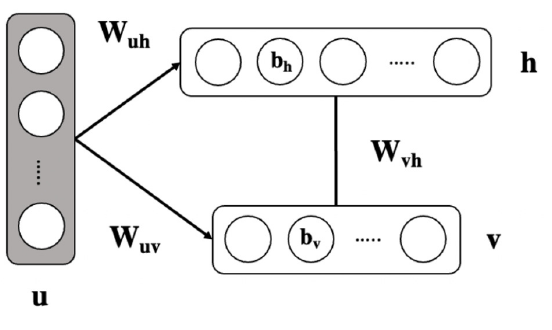
Figure 2. A CRBM with one conditional layer that connects to both the hidden layer and visible